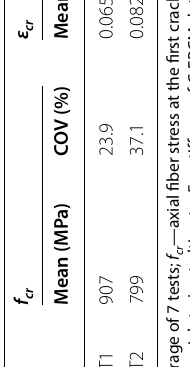
Fig. 8 Tensile test results: C-FRCM with one layer of fabric.